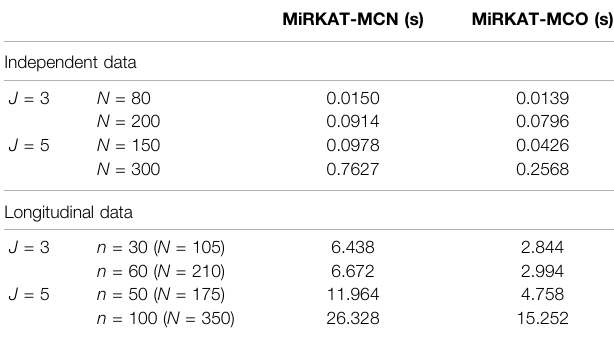
TABLE 4 | Computation ef fi ciency of MiRKAT-MC. Each result isthe average time of one association test averaged from running 100 replicate association